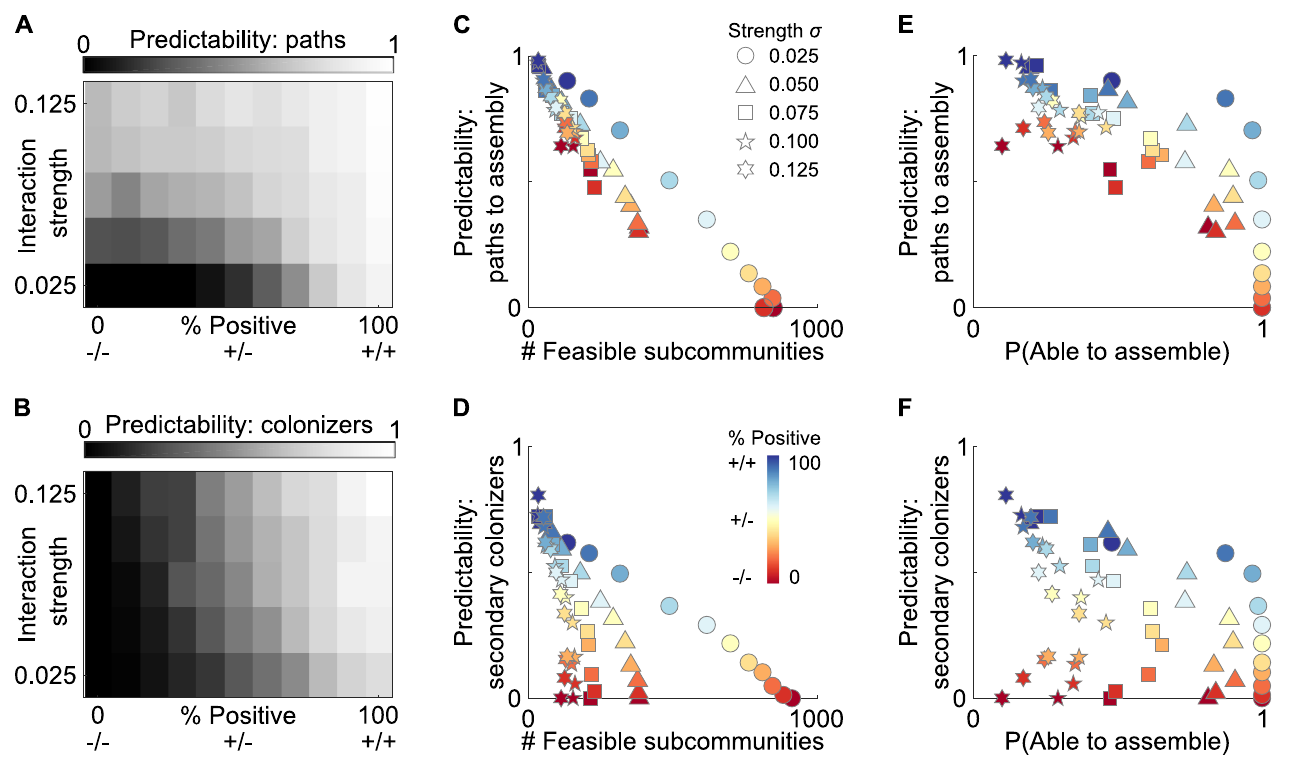
Fig 3. Strong, positive interactions increase the predictability of assembly. (A) Increasing interaction strength, and the number of positive interactions, decreases the number of edges within the assembly map. ( B) Strong and positive interactions also increase the incidence of secondary colonizers, who cannot establish within the community until other species are present. Together, these factors increase the overall predictability of community assembly. ( C, D ) Increased predictability stems in part from a lower number of feasible subcommunities. ( E, F) The relationship between interaction strength and sign and predictability leads to a trade-off between the robustness and predictability of assembly. For all analyses, climax communities are drawn with S = 10, connectivity C = 0.5, from 150 independent replicates, underlying data in S3 Data.